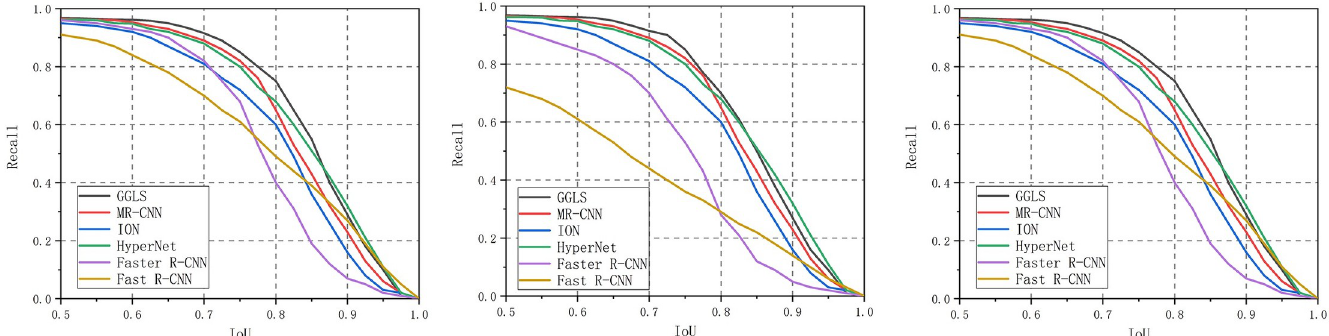
Fig 13. Recall versus IoU threshold on the VOC 2007 test set. Left: 150 region proposals. Middle: 450 region proposals. Right: 850 region proposals.